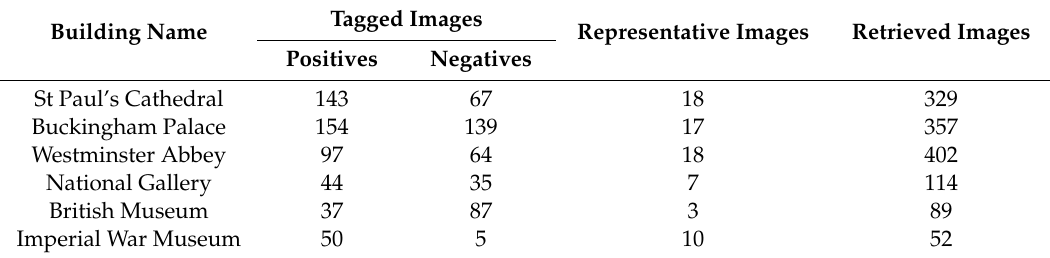
Table 2. Statistics of each kind of image for each selected building. Tagged images: tagged with building name, retrieved images: retrieved based on representative images.